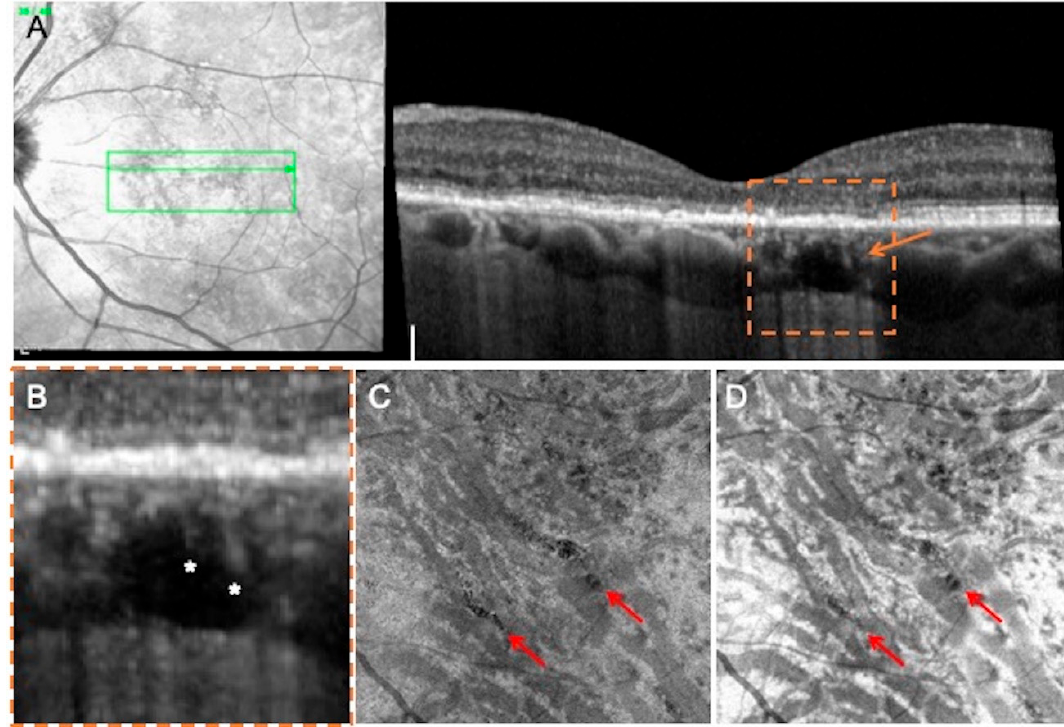
Figure 2. Multimodal imaging of a patient affected by chronic CSC and presenting a choroidal rift. ( A ) OCT B-scan and relative IR image shows the presence of a choroidal rift (orange arrow) crossing the outer choroidal layers. ( A ) magnified visualization of this region; ( B ) reveals the presence of hyperreflective vertical filiform-shaped structures (white asterisks). En face angiographic ( C ) and structural ( D ) OCT images revealed that choroidal rifts (highlighted with the red arrows) seem to be interruptions of the choroidal stroma in correspondence of fragile regions (in between major-sized choroidal vessels).